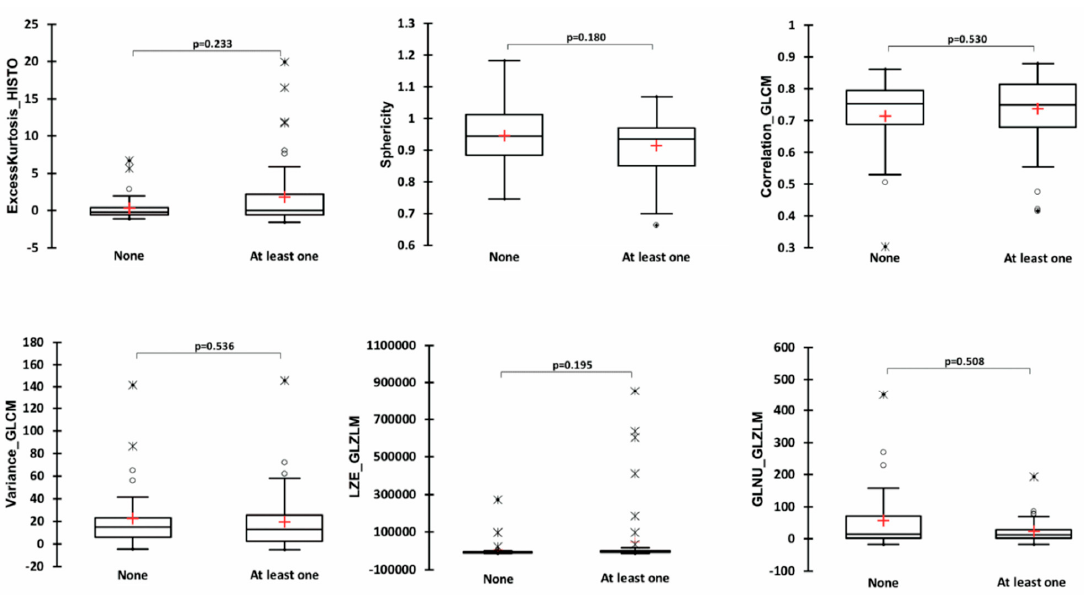
Figure 3. Comparison of patients without any molecular alteration and patients with at least one in terms of all positron emission tomography quantitative variables included in the model.